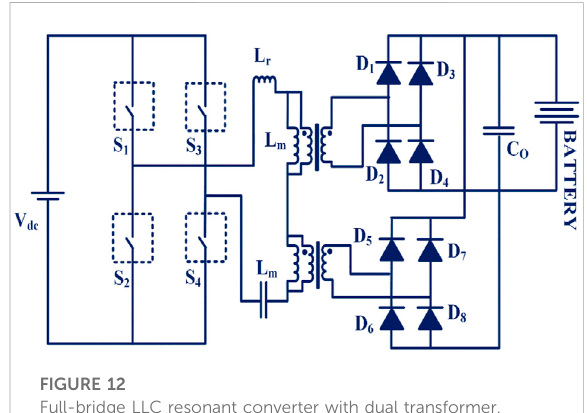
FIGURE 12 Full-bridge LLC resonant converter with dual transformer.